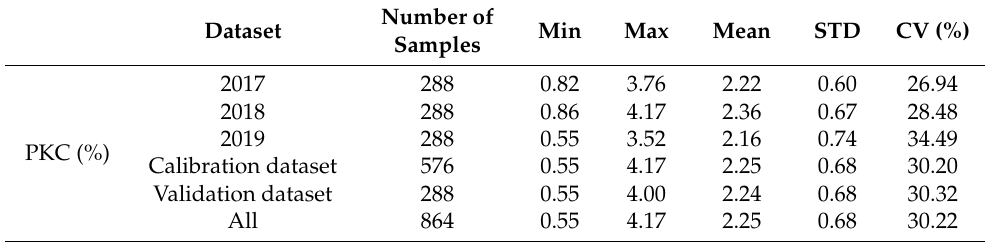
Table 2. Statistics of PKC (%) for all 6 sampling times (tillering, productive tiller critical stage (N-n), jointing, booting, heading, and filling stage) for experiments conducted in 2017, 2018, and 2019.